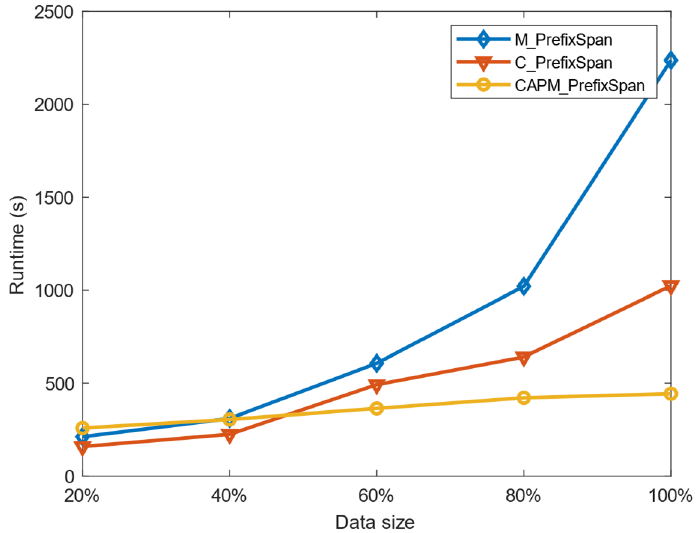
Figure 4. Runtime with di ff erent sizes of alarm fl ood sequence databases.